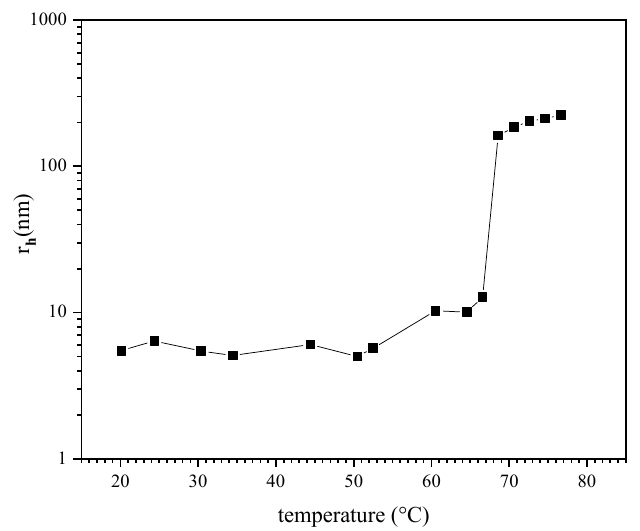
Figure 3. Hydrodynamic radius of a P (TEGA-co-SPA) copolymer in aqueous solution upon heating as determined from DLS measurements.